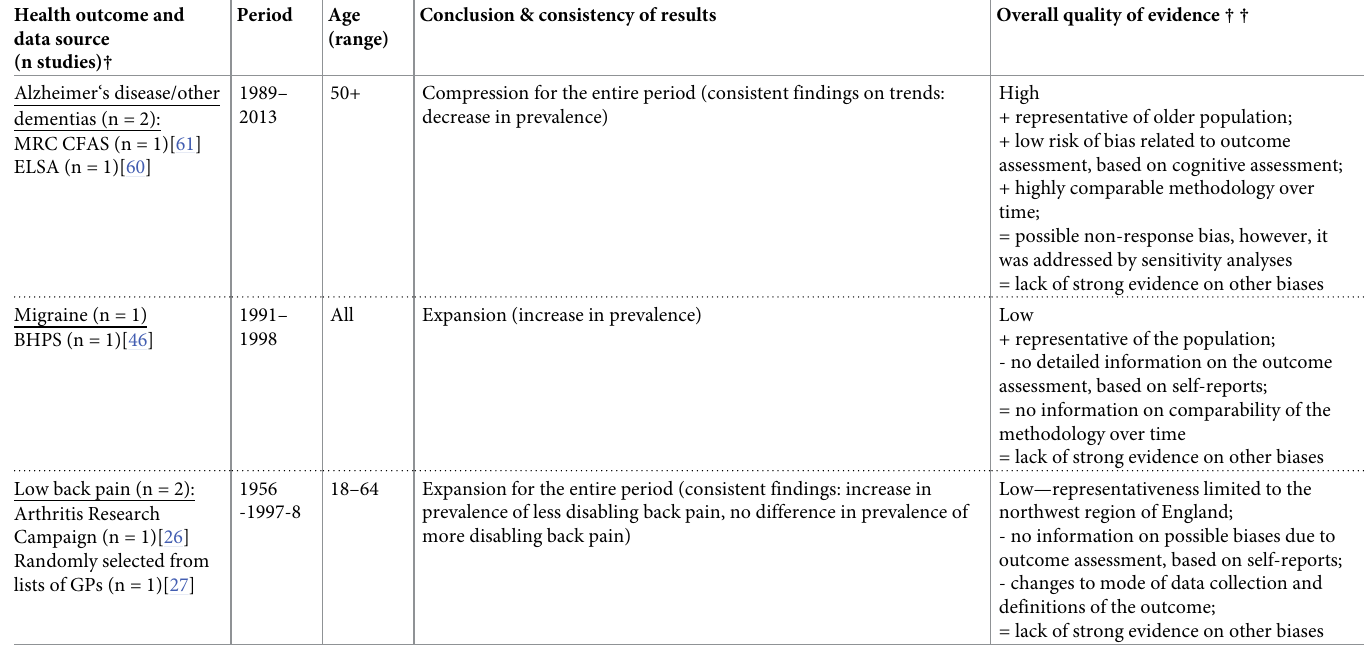
Table 5. The characteristics of evidence on prevalence of each health outcome, with the emphasis on size, consistency and quality (cont.). Health outcome and data